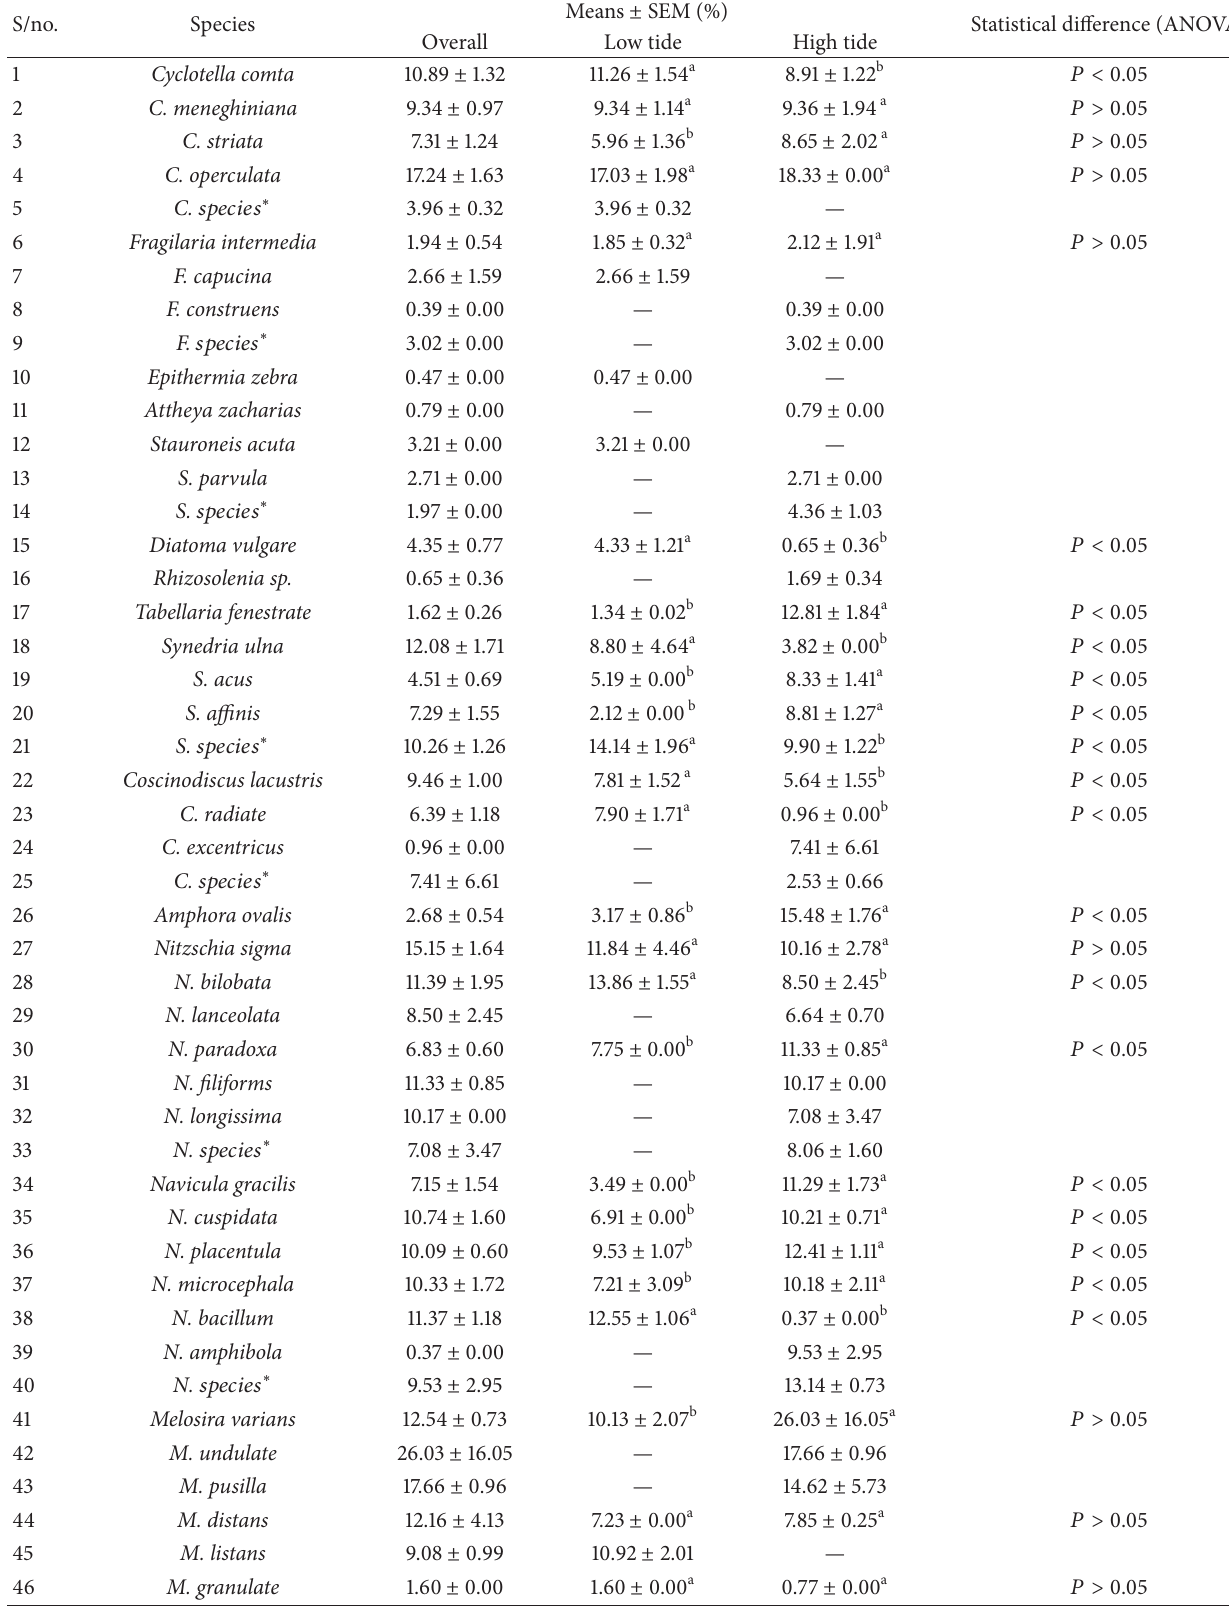
Table 3: Variations of Bacillariophyceae species under tidal influence in Okpoka